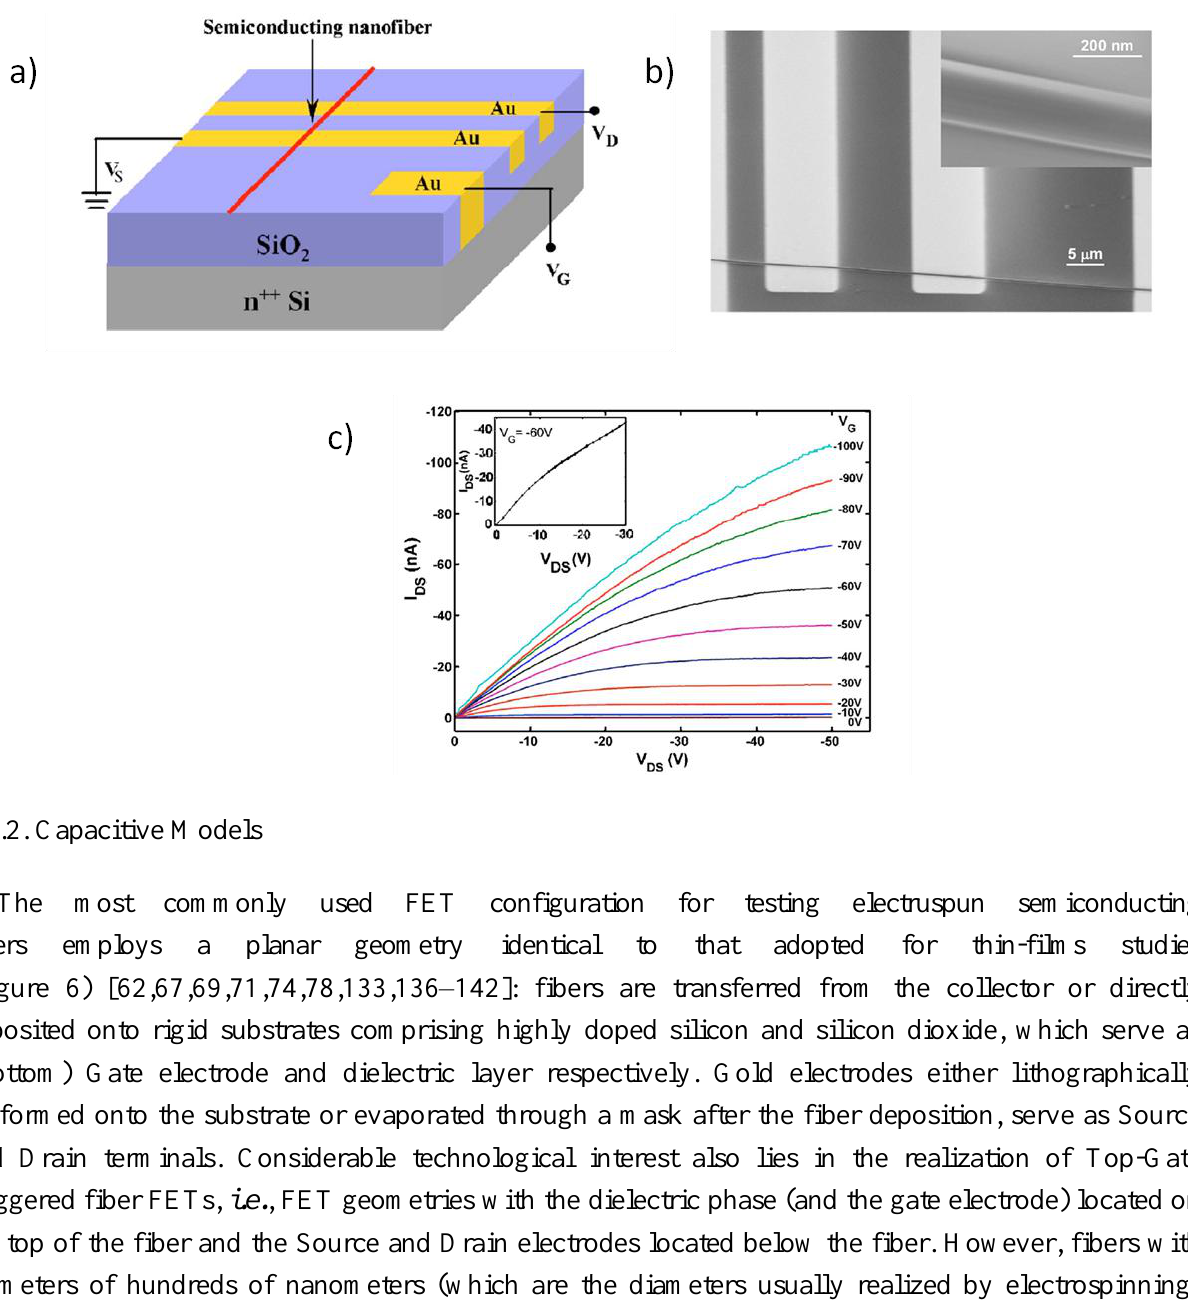
/Si substrate and ( c ) I vs. 2 ds